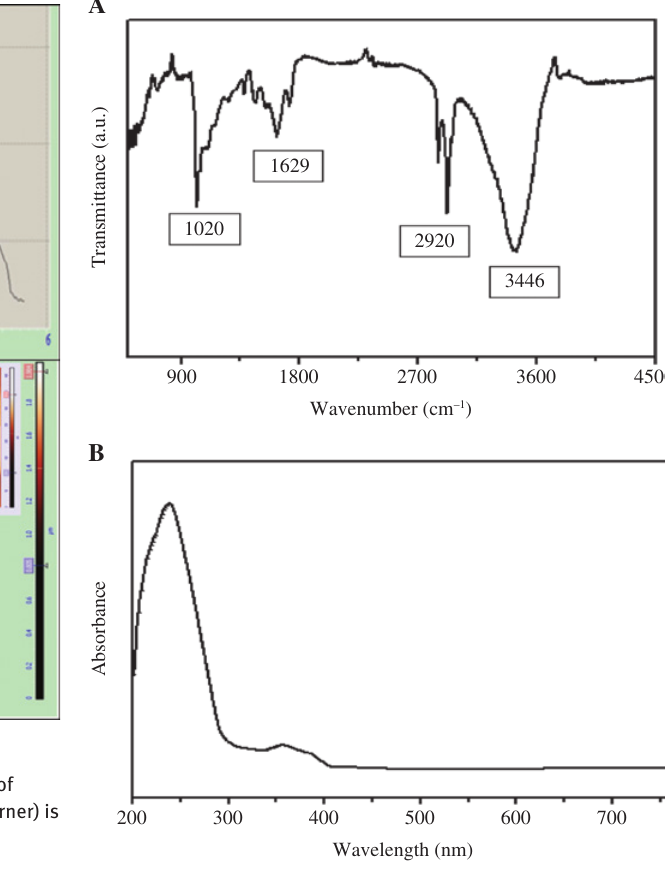
Figure 8: FTIR and UV-Vis analysis. (A) FTIR spectrum of GNs. (B) UV-Vis spectrum of GNs in